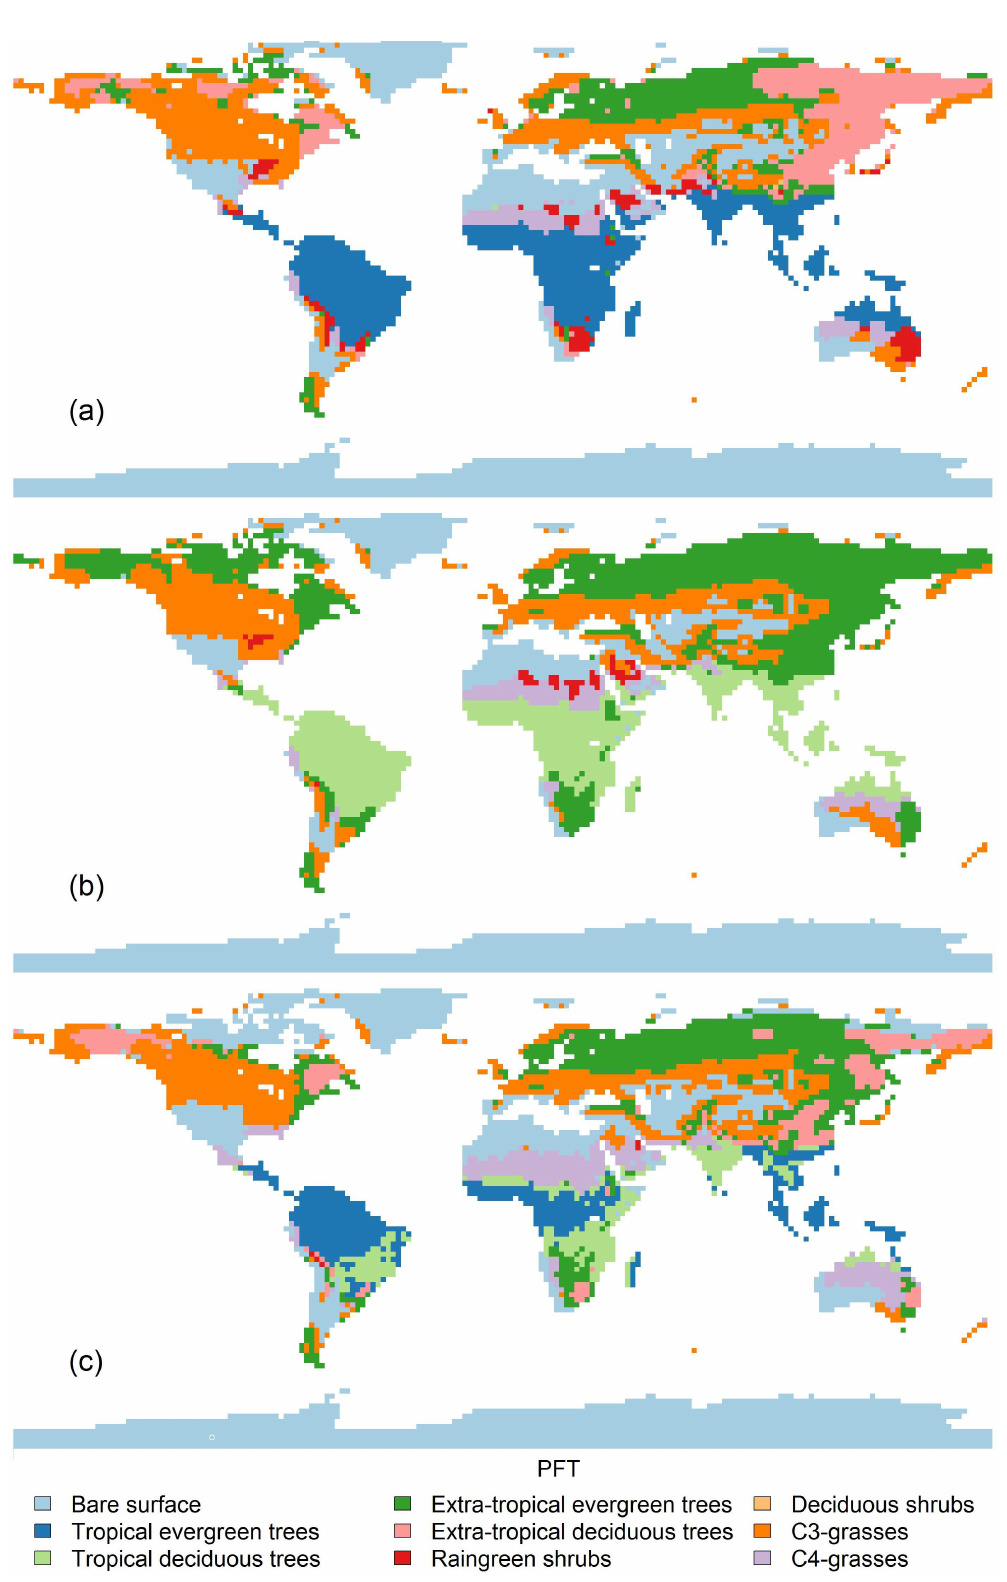
Fig. 5. Global distribution of dominant PFTs. (a) Default simulation, (b) observed traits simulation and (c) variable traits